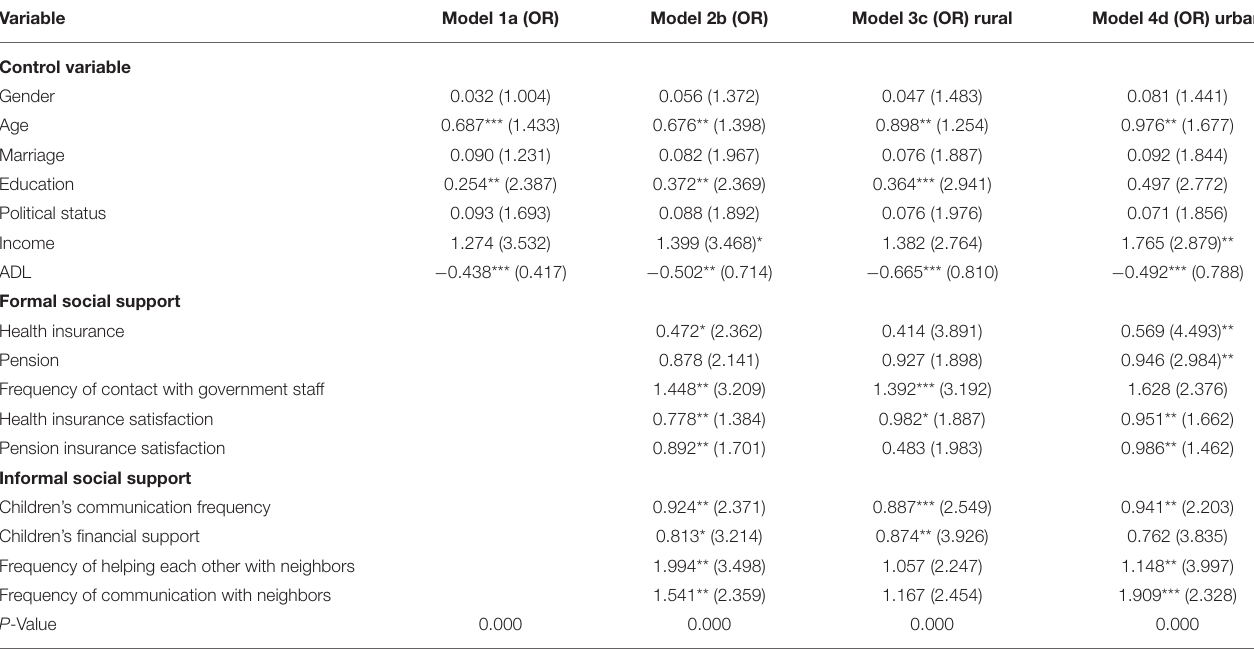
TABLE 6 | The impact of social support on utilization of preventive healthcare services.